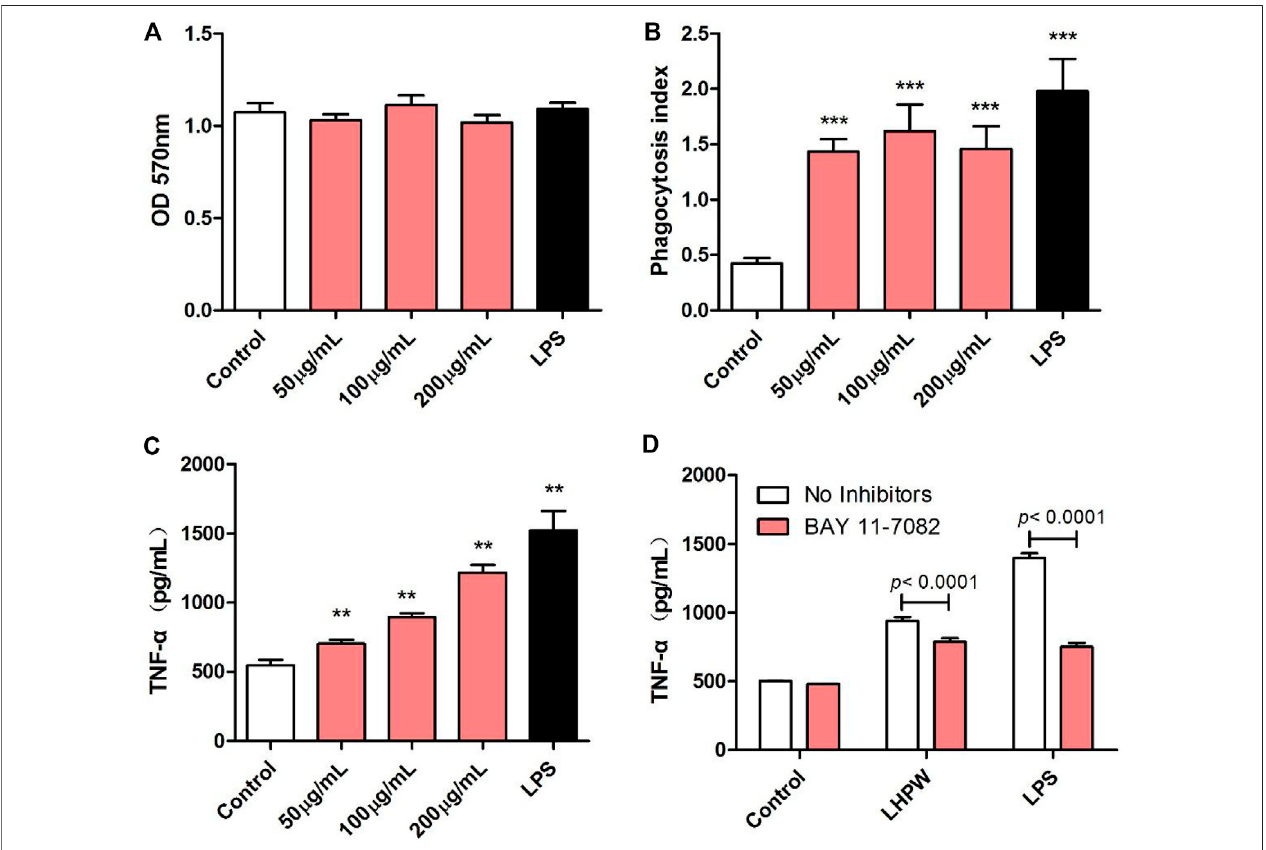
FIGURE 4 | Effects of LHPW on the phagocytosis index, TNF- α production of RAW 264.7 cells. After RAW 264.7 cells were treated with various concentrations of LHPW (50, 100, and 200 μ g/ml), the cell cytotoxicity (A) , neutral red phagocytosis index (B), and TNF- α production (C) were tested. Data shown were mean ± SD of three independent experiments. ( ppp ) p < 0.001, ( pp ) p < 0.01, and ( p ) p < 0.05comparedwith the control. (D) RAW 264.7 cells werepretreated with PBS(No inhibitors) or BAY 11-7082 (3 µM) for 1 h before incubation with 200 μ g/ml LHPW or 2 μ g/ml LPS for 24 h.